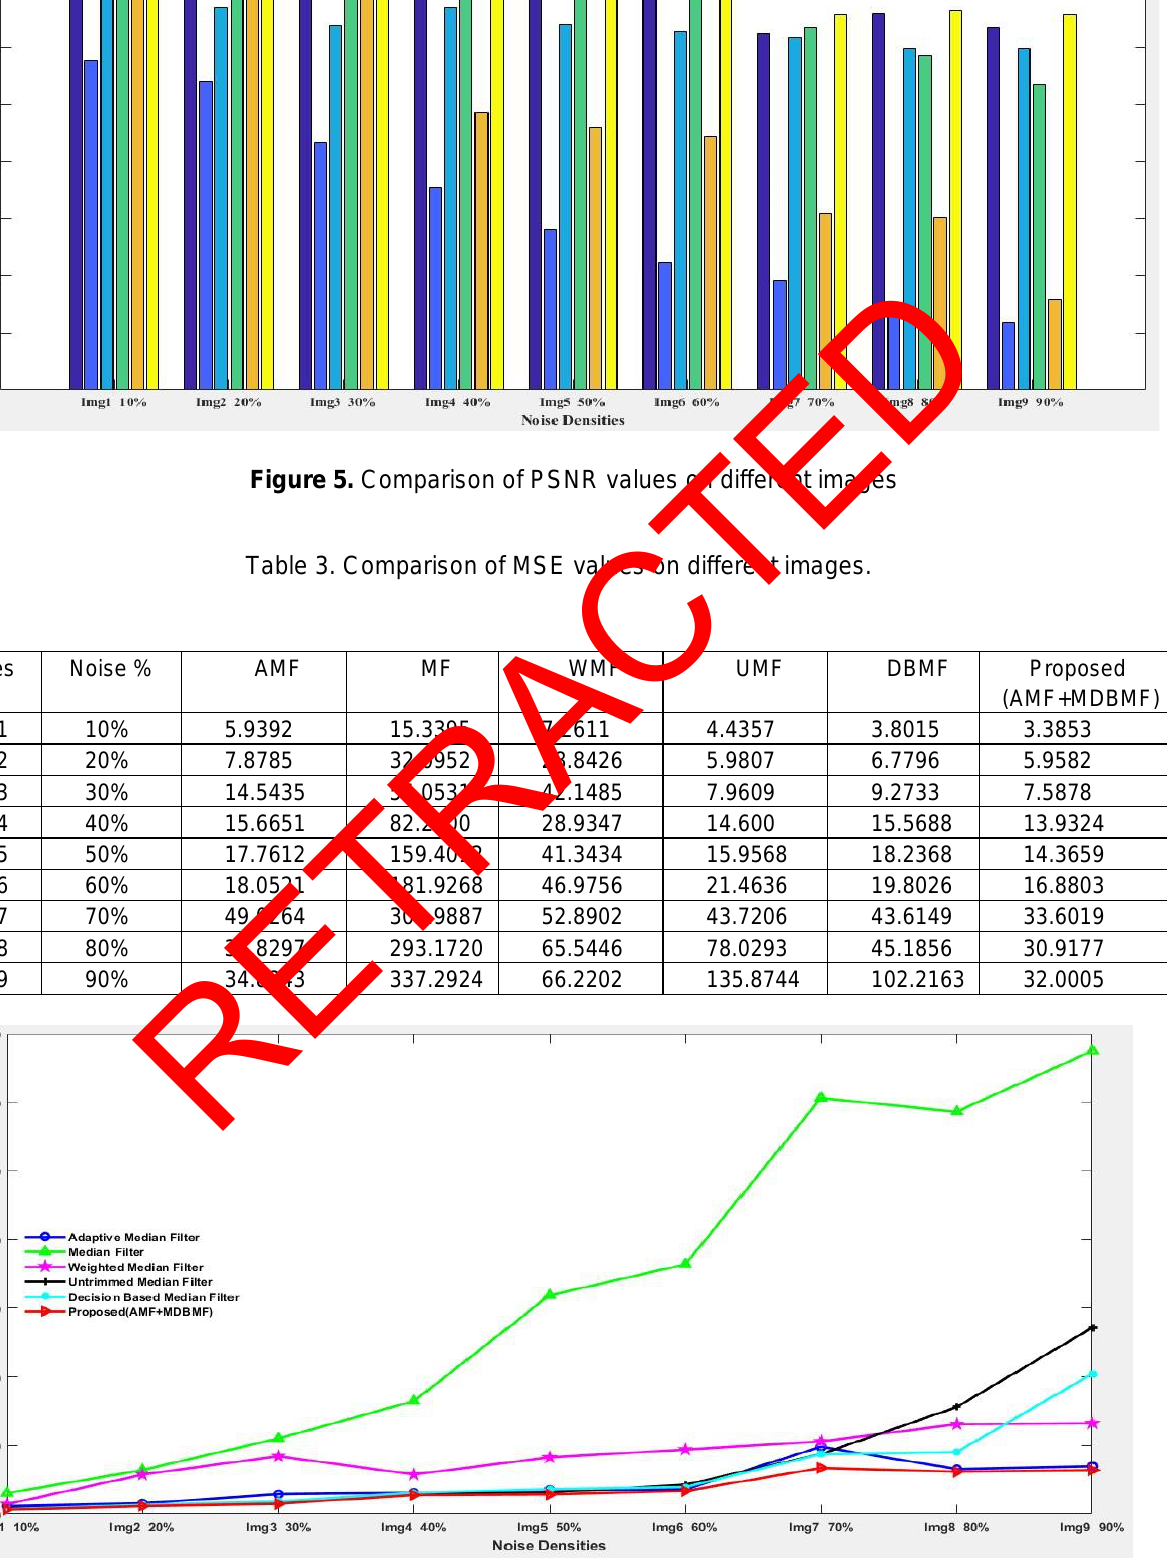
Figure 6. Comparison of MSE values on different